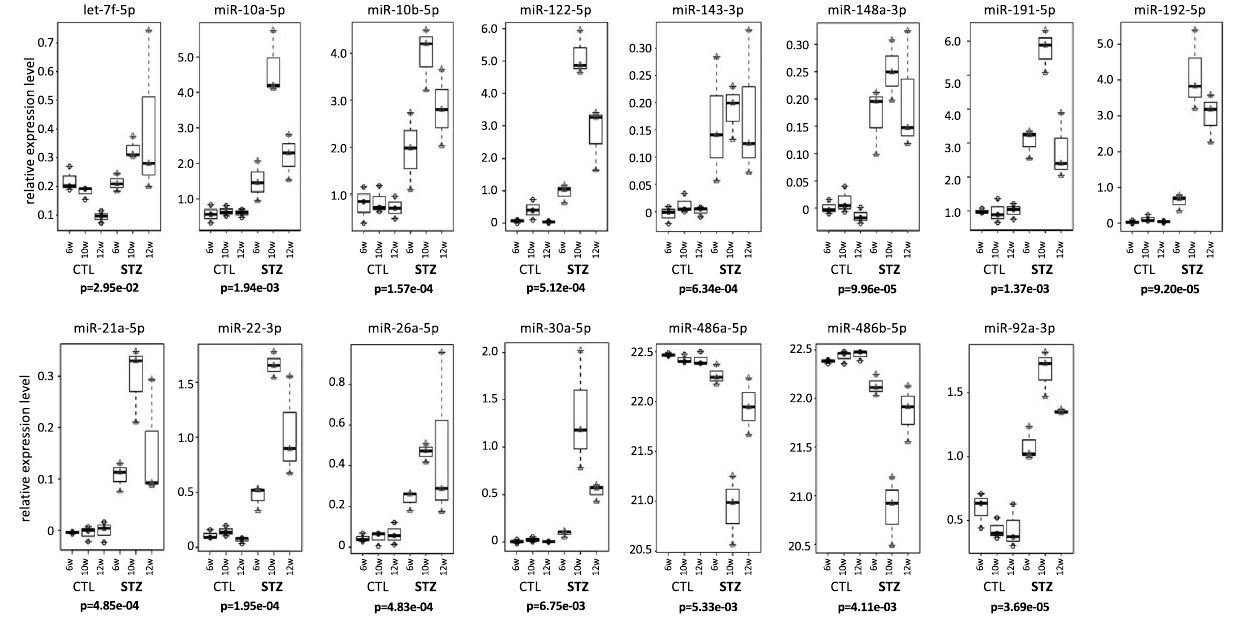
Figure 4. Expression pattern of miRNA in the exosome rich fraction. The expression level of 15 miRNAs from serial collection (6, 10, and 12 W) is shown for STZ-mice and CTL-mice. Statistical analysis was performed using the student-t test, and a difference was considered statistically significant for a p < 0.05 (bold letter). The vertical axis represents the expression level of miRNA.